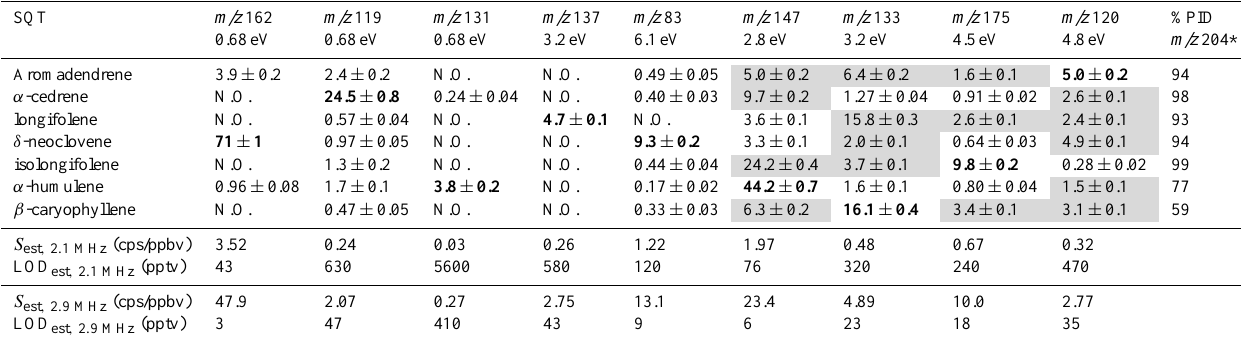
Table 4. Fragmentation fractions (FF) for SQT + fragment ions. Values shown in bold are associated to SQTs for which the corresponding fragment ion at the specified E CM value can be considered as a tracer when analyzing mixtures containing the seven SQTs studied. Tracer fragment ions for aromadendrene, β -caryophyllene and isolongifolene were only found for restricted sets of SQTs, which do not comprise those compounds for which the FF value is shown against a grey background. Results are not corrected for mass discrimination effects. Also shown is the estimated sensitivity and LOD (based on a 20s dwell time) of a hypothetical PTR-SRI-TMS instrument for the detection of individual SQTs (associated to FF values in bold) by monitoring the corresponding tracer fragment ions. The estimated sensitivity and LOD values are given for two distinct values of the RF frequency (2.1 and 2.9MHz) of the voltages on the collision cell octupole rods (see text). SQT